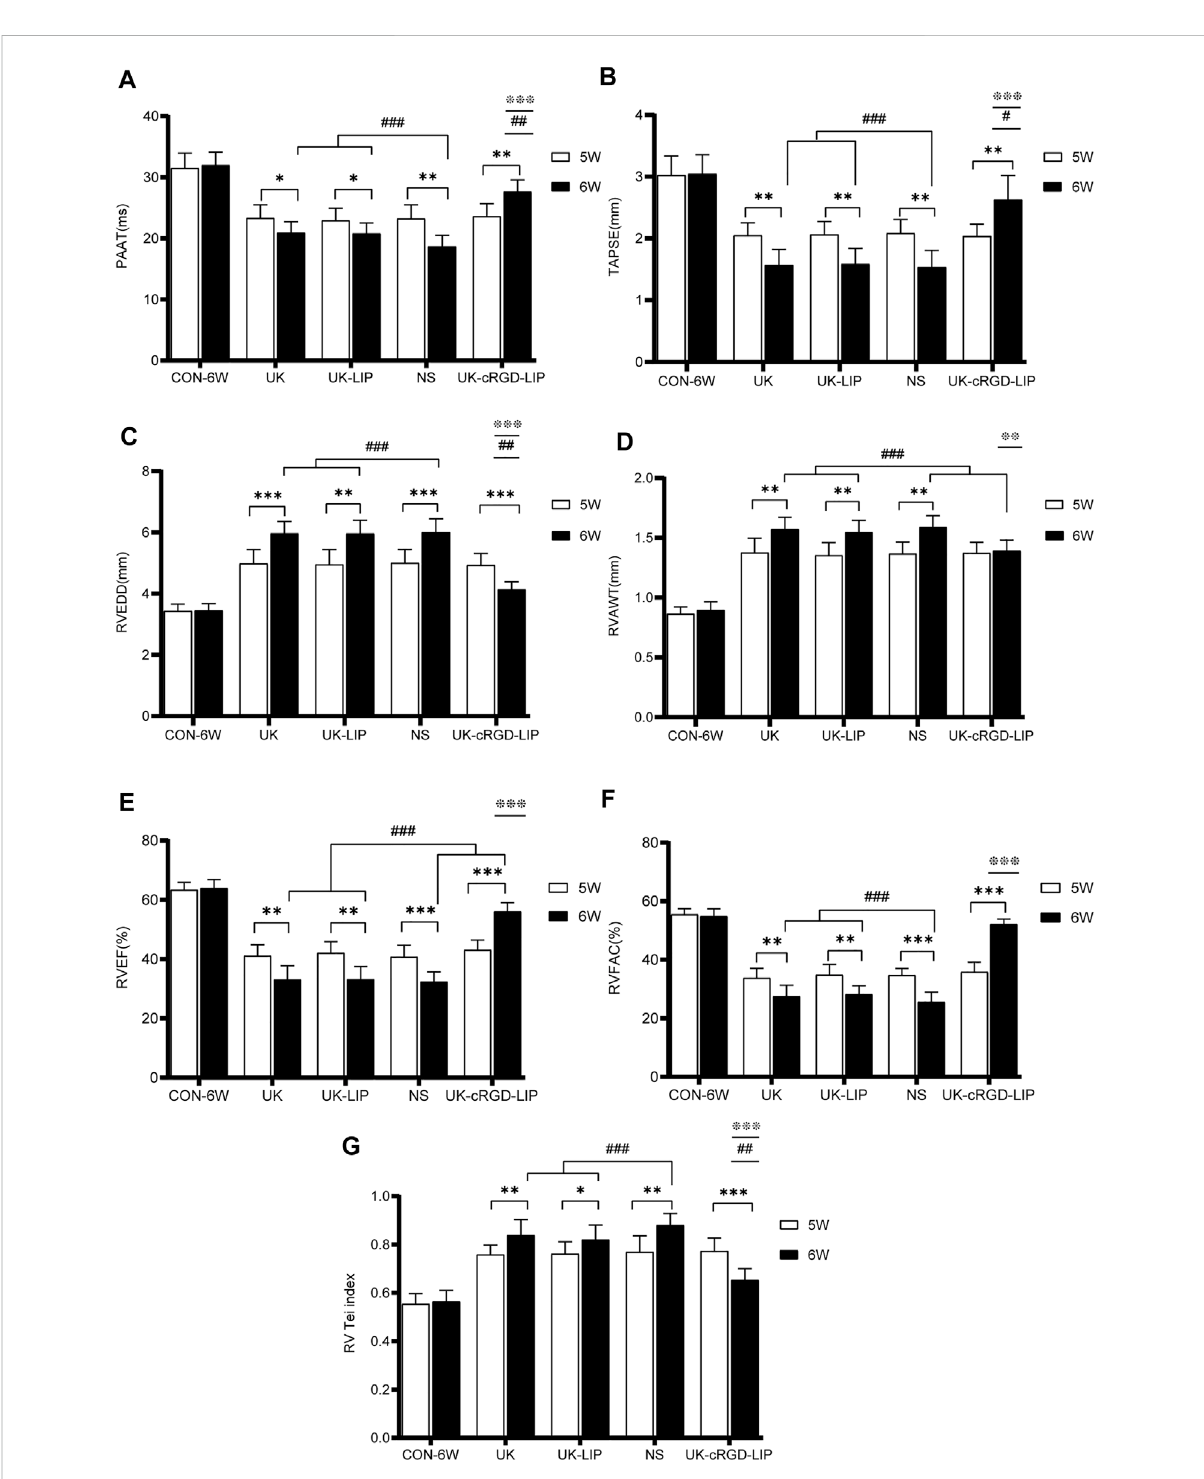
FIGURE 9 Echocardiography parameters of right ventricular function and morphology. (A – G) Analysis of PAAT, TAPSE, RVEDD, RVAWT, RVEF, RVFAC, RV TeiindexfromCON-6W,UK,UK-LIP,NS,andUK-cRGD-LIPrats.ValueswerepresentedasMean±SD.Data(CON-6W, n =10;UK, n =8;UK-LIP, n = 8; NS, n = 8; UK-cRGD-LIP, n = 9) were analyzed by unpaired Student ’ s t-test or one-way ANOVA. * p < 0.05, ** p < 0.01, and *** p < 0.001. # p < 0.05, ## p < 0.01,and ### p < 0.001vs.CON-6W(6W). ❉ p < 0.05, ❉❉ p < 0.01,and ❉❉❉ p < 0.001vs.UK(6W),UK-LIP(6W),orNS(6W).Abbreviations:5W,pre thrombolytic therapy; 6W, post thrombolytic therapy; PAAT, pulmonary artery acceleration time; RVEDD, right ventricular end-diastolic transverse diameter; TAPSE, tricuspid annular plane systolic excursion; RVEF, right ventricular ejection fraction; RVFAC, right ventricular area change fraction; RV Tei index, right ventricular myocardial work index; RVAWT, right ventricular anterior wall